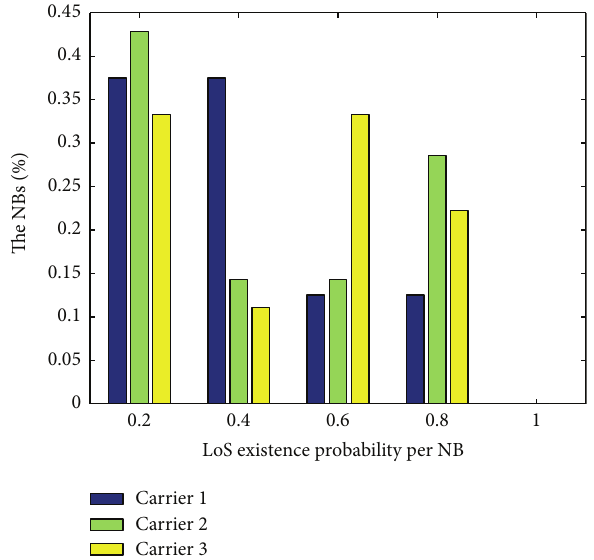
Figure 14: The empirical percentage of LoS existence probability per